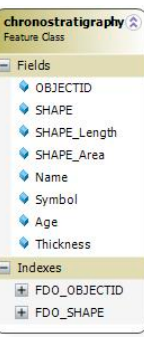
Figure 9. Feature field design of a fold axis.